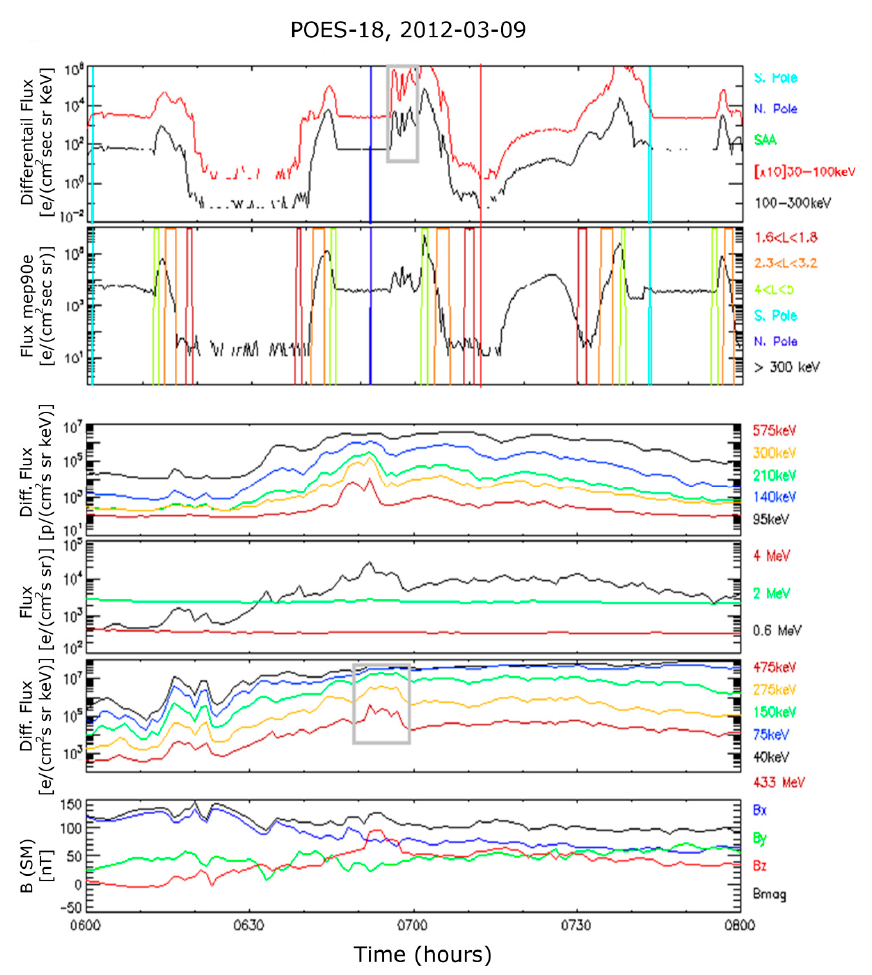
Figure 4. (From top to bottom) POES (NOAA) 18 electron fluxes in the upper ionosphere and proton and electron fluxes along with magnetic field measurements as observed by the geostationary GOES 13 satellite. A comparison of observations suggests that during a dipolarization of the magnetic field and an electron injection event observed by GOES 13, a great amount of precipitating electrons was observed (NOAA 18) in a large portion of the northern upper ionosphere. Figure 4 shows NOAA 18 satellite electron fluxes (two upper panels) and ion flux (third panel) in comparison with simultaneous observations from the geostatic satellite GOES 13: Low ‐ energy proton flux (third panel from the top), high and low ‐ energy elec ‐ tron fluxes (fourth and fifth panel from the top), and the magnetic field components Bx, By, and Bz along with the total magnetic field magnitude B (bottom panel). The observa ‐ tions shown in this figure were obtained during the time interval 06:00–08:00 UT on March 9, 2012. In the two upper panels of Figure 4, the NOAA 18 electron observations show three major flux structures at times < ≈ 06:20 UT, ≈ 06:40–07:11 UT and after ≈ 07:13 UT. These three major flux enhancements correspond to the NOAA 18 satellite successive south–north–south parts of its orbit. The energy ranges of each line in the panels with proton and electron measurements are indicated on the right. The pairs of green and